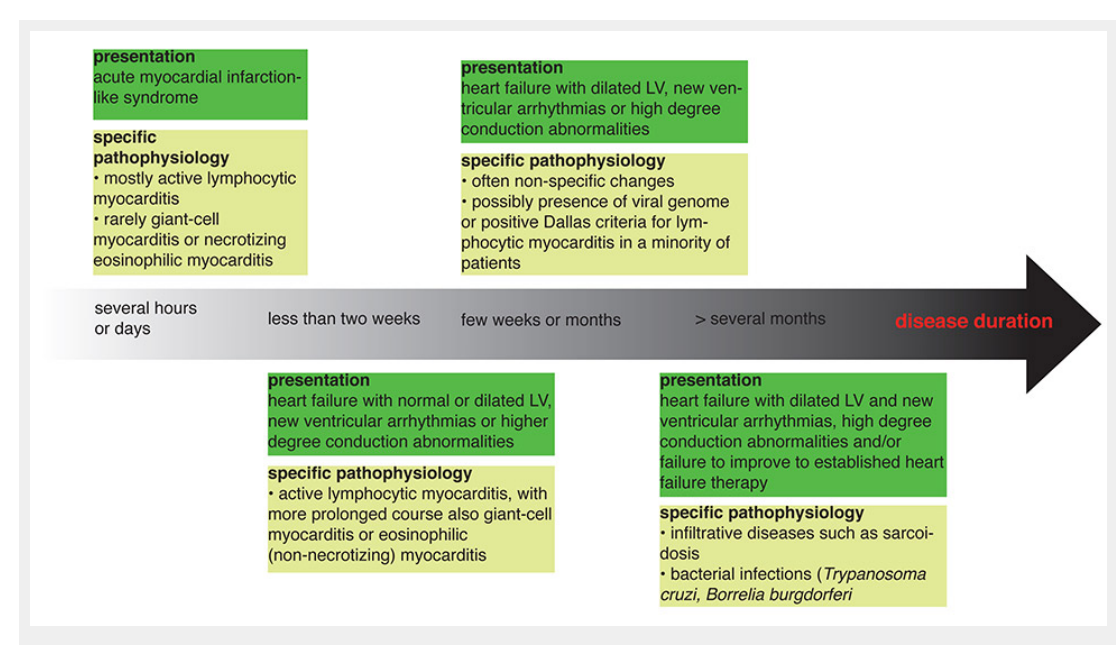
The common clinical presentations of myocarditis and possible specific pathologies. The scheme is adapted from [64]. LV = left